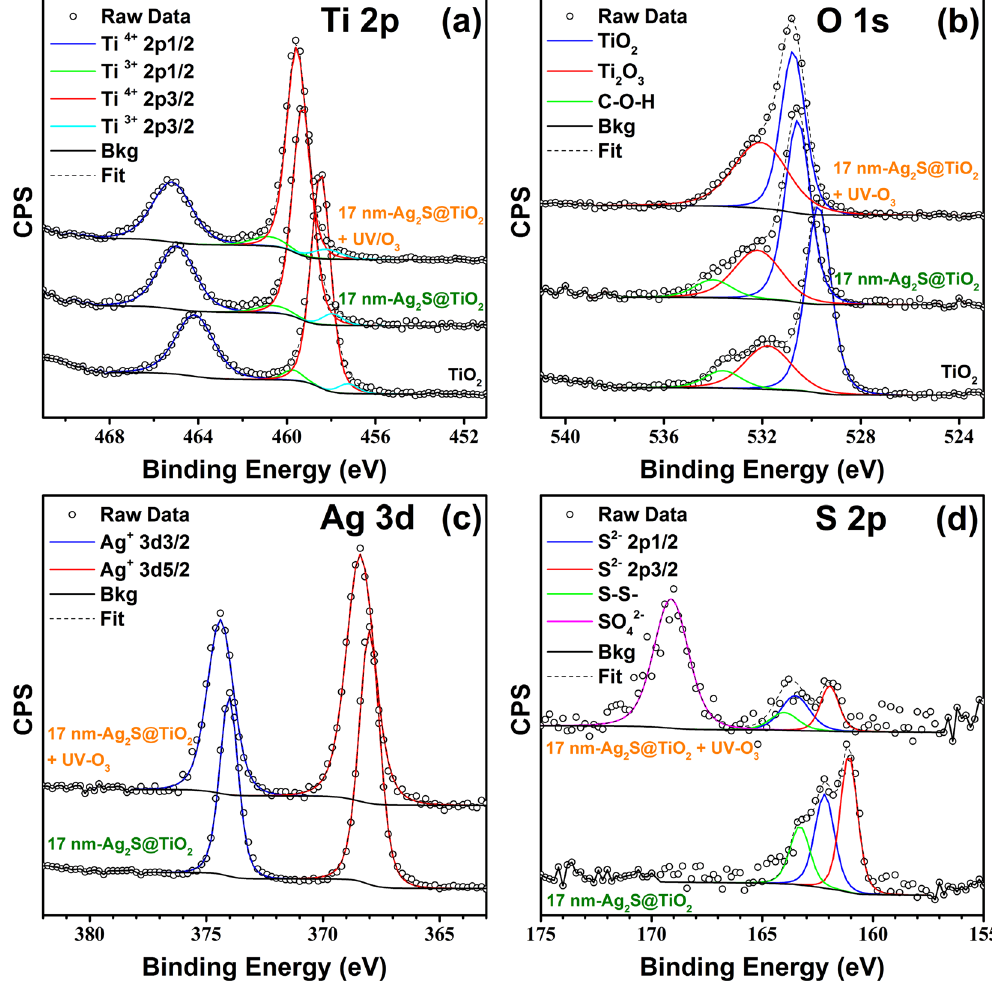
Figure 5. XPS spectra of pure TiO 2 , 17 nm-Ag 2 S@TiO 2 and 17 nm-Ag 2 S@TiO 2 + UV-O 3 samples. ( a ) Ti 2p, ( b ) O 1 s, ( c ) Ag 3d, and ( d ) S